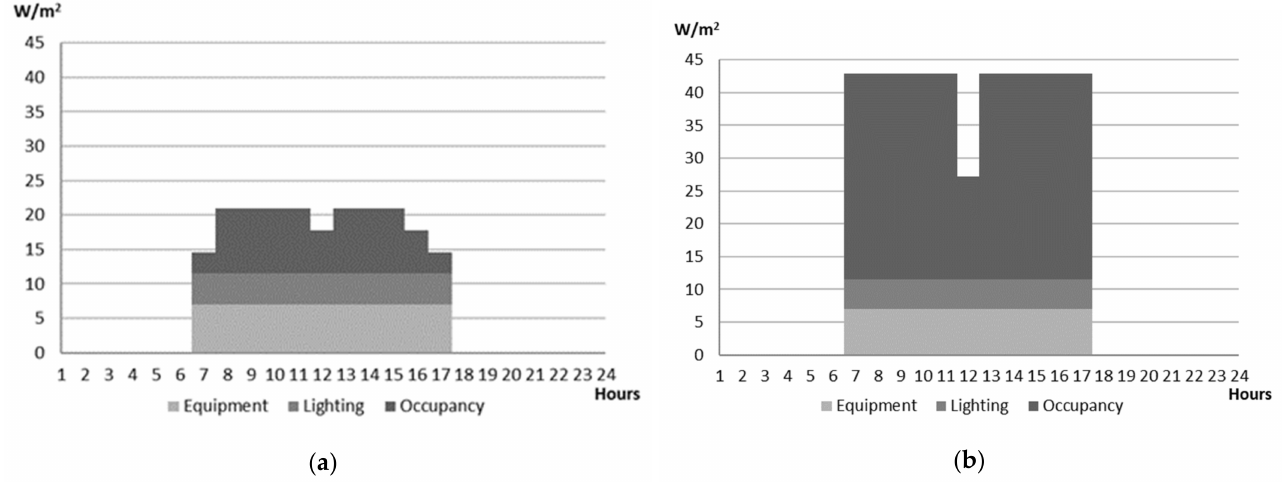
Figure 4. Internal heat loads in ( a ) office room; ( b ) meeting